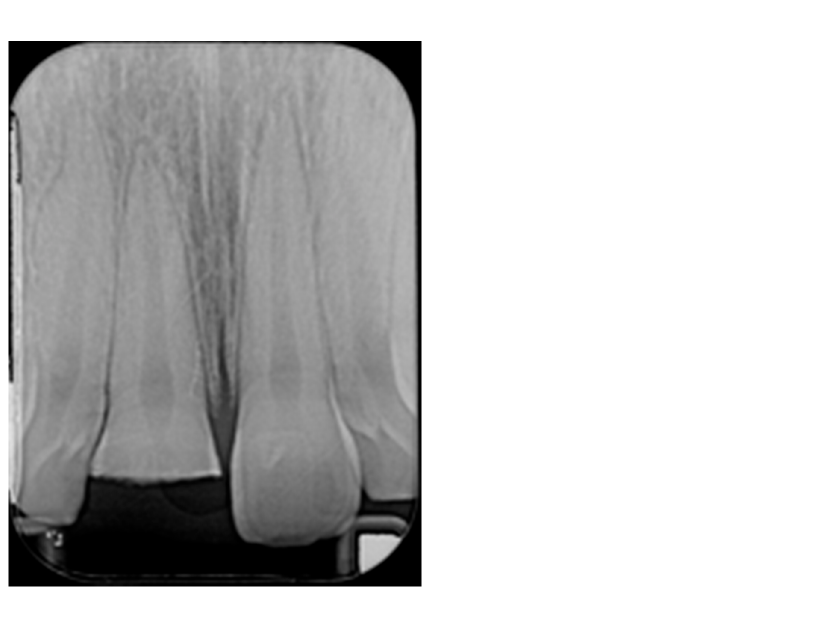
Figure 2. Initial x-ray. Reprinted from Restauri diretti nei settori anteriori, G. Paolone, S. Scolavino, © 2021, with permission from Quintessence Publishing Italy.